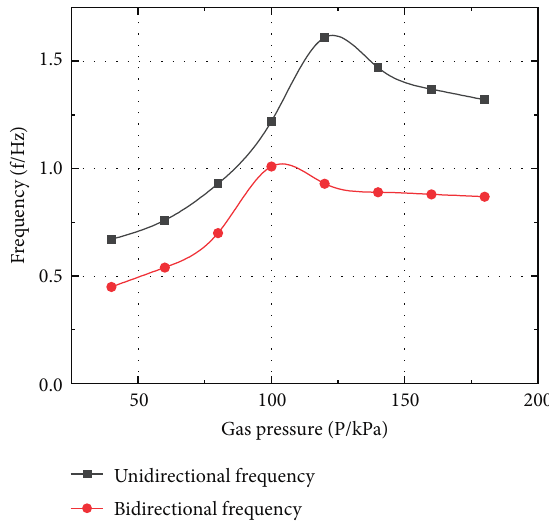
Figure 8: The P − f characteristic curves of pneumatic soft-bodied bionic basic execution